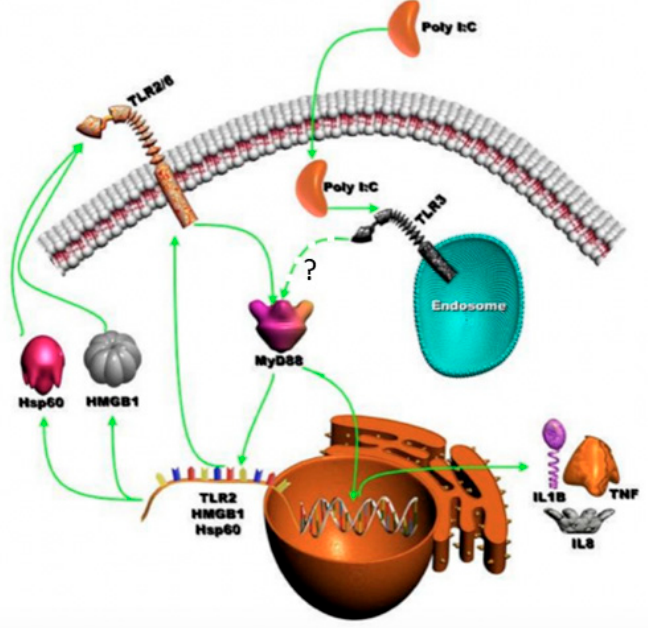
Figure 11. Schematic diagram of the TLR3-dependent activation of MyD88 signaling: TLR3 activation triggers endogenous ligands of TLR2 (HMGB1 and Hsp60) via the usage of the MyD88 signaling pathway. These endogenous TLR2 ligands then stimulate TLR2 signaling to augment the innate immune responses.